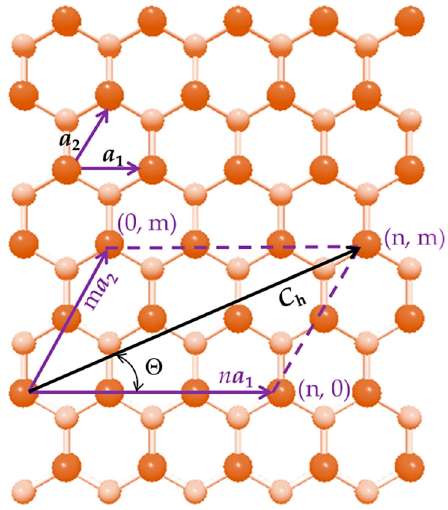
Figure 1. Schematic of the unrolled hexagonal AlP sheet; chiral indices, n and m, chiral vector, C h , and chiral angle, Θ , are depicted. P atoms are represented in pale brown; Al atoms are bright brown. Table 1. Bond length values of phosphide nanostructures available in the literature. BP AlP GaP InP a A13 - P , nm